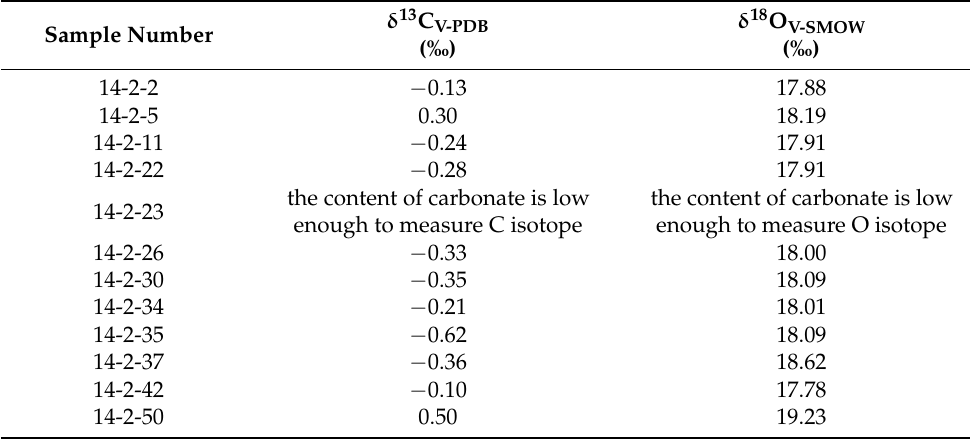
Table 4. Carbon-oxygen isotope data of Sparkling Lake calcareous tufa